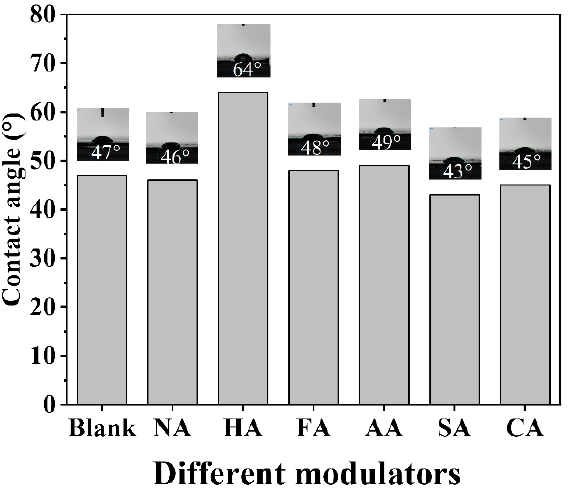
Figure 7. Contact angles of the blank sample and MIL-101 (Cr, Sn) synthesized with different modulators.